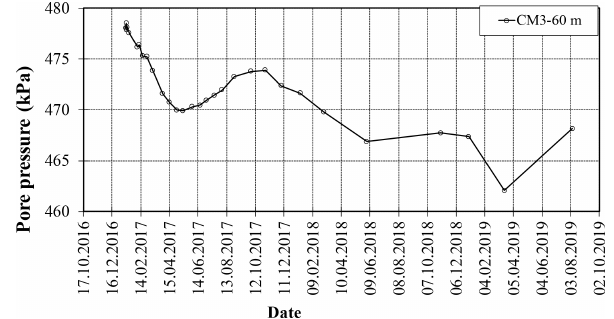
Figure 7. Example of change in pore pressure with time for piezometer at 60m depth, CM3